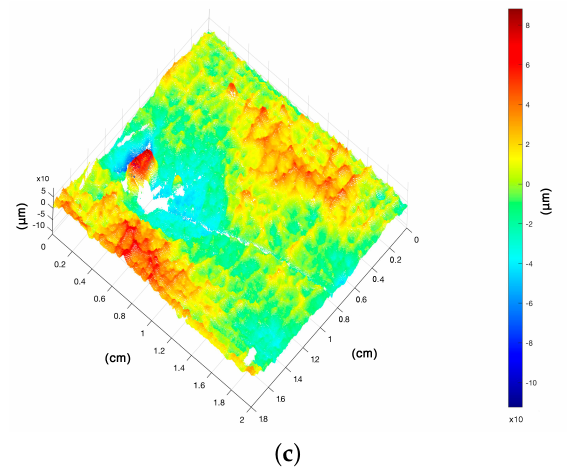
Figure 8. Surface data of an ROI around the eye sampled at 25µm step: ( a ) 2D height map, ( b ) line profiles of the highlighted row (blue) and column (orange) and ( c ) representation of data as a point cloud in space that can be interactively explored by the insiders.